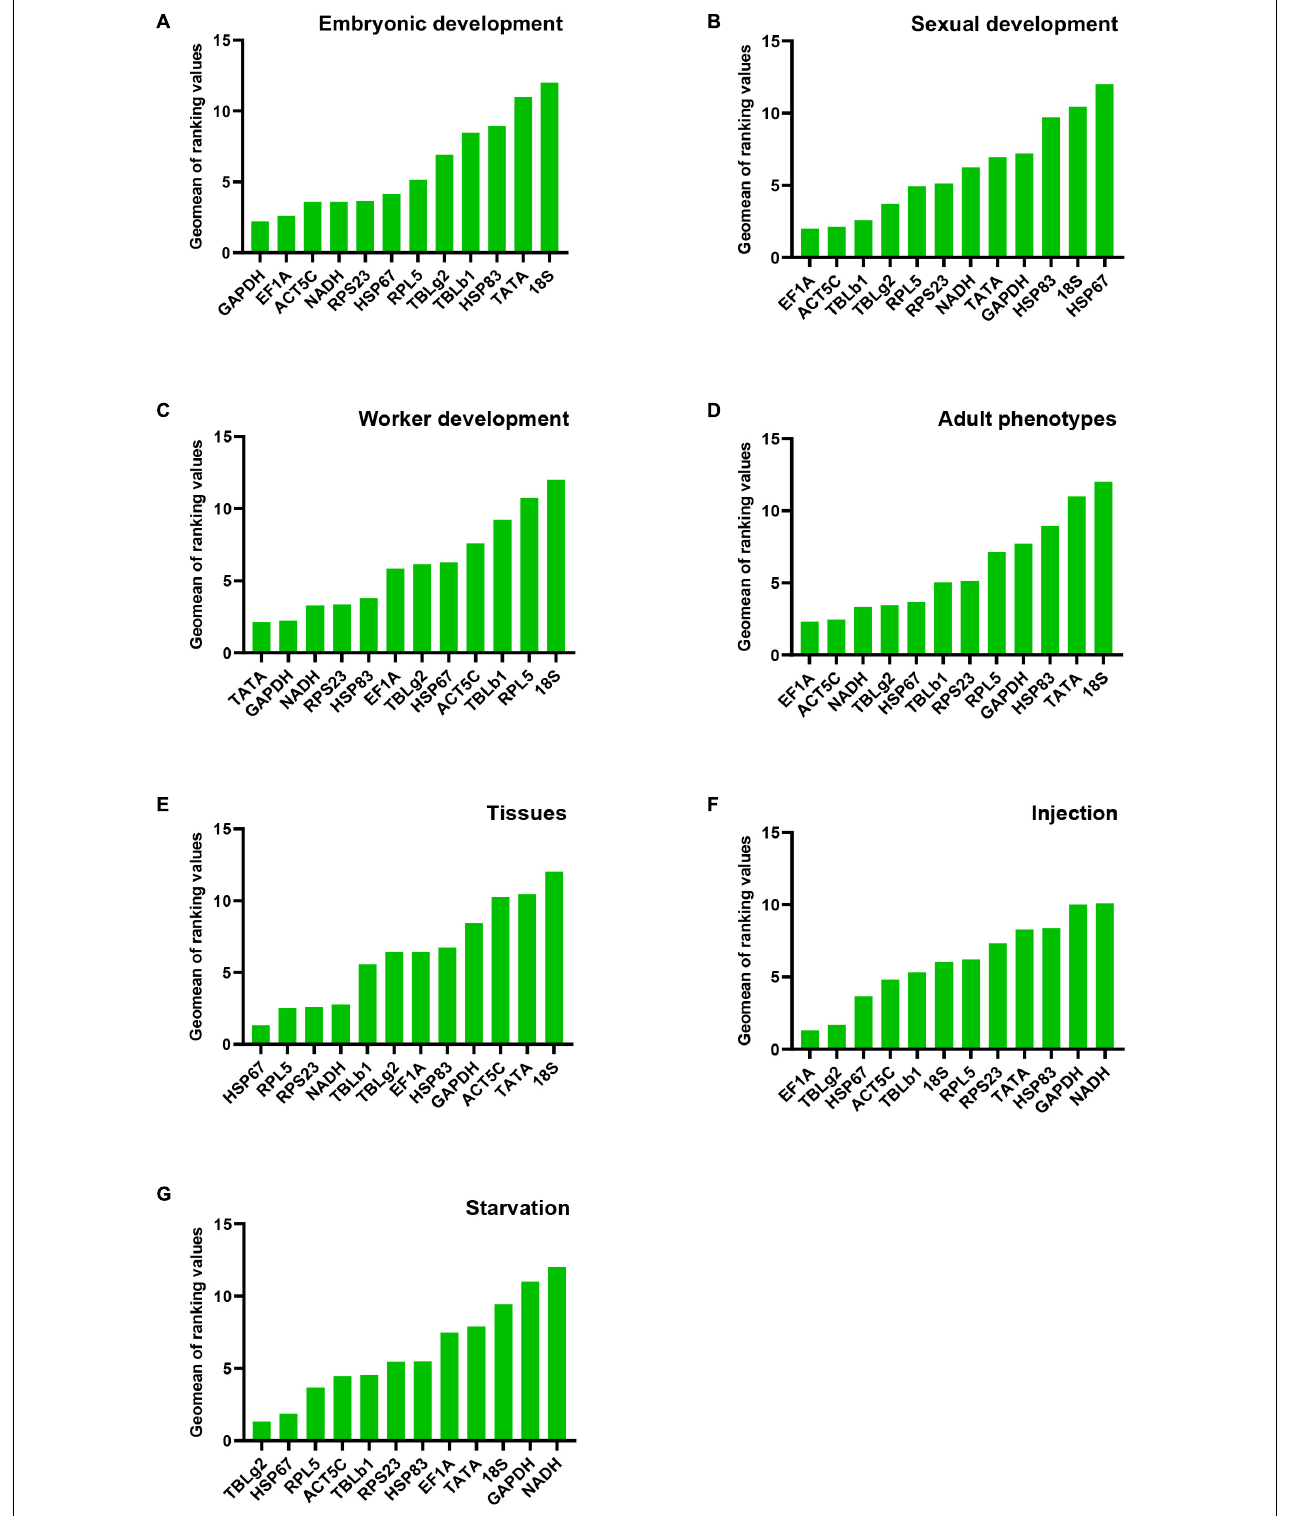
FIGURE 2 | Stability of candidate reference gene expression in M. pharaonis in conditions of embryonic development (A) , sexual development (B) , worker development (C) , adult phenotypes (D) , tissues (E) , injection (F) , and starvation (G) . The stability of reference gene expression was calculated by RefFinder, which summarizing four different algorithms (geNorm, Norm finder, BestKeeper, and comparitive (cid:49) Ct). A lower value means more stable expression.